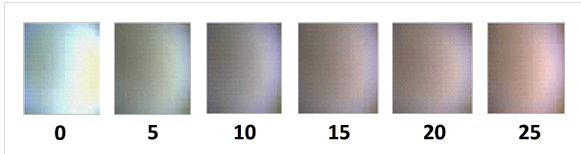
Figure 2: The color of the plasma corresponding to the six increasing values of the input flux described in Figure 1 (0 sccm is the leftmost, 25 sccm is the rightmost).